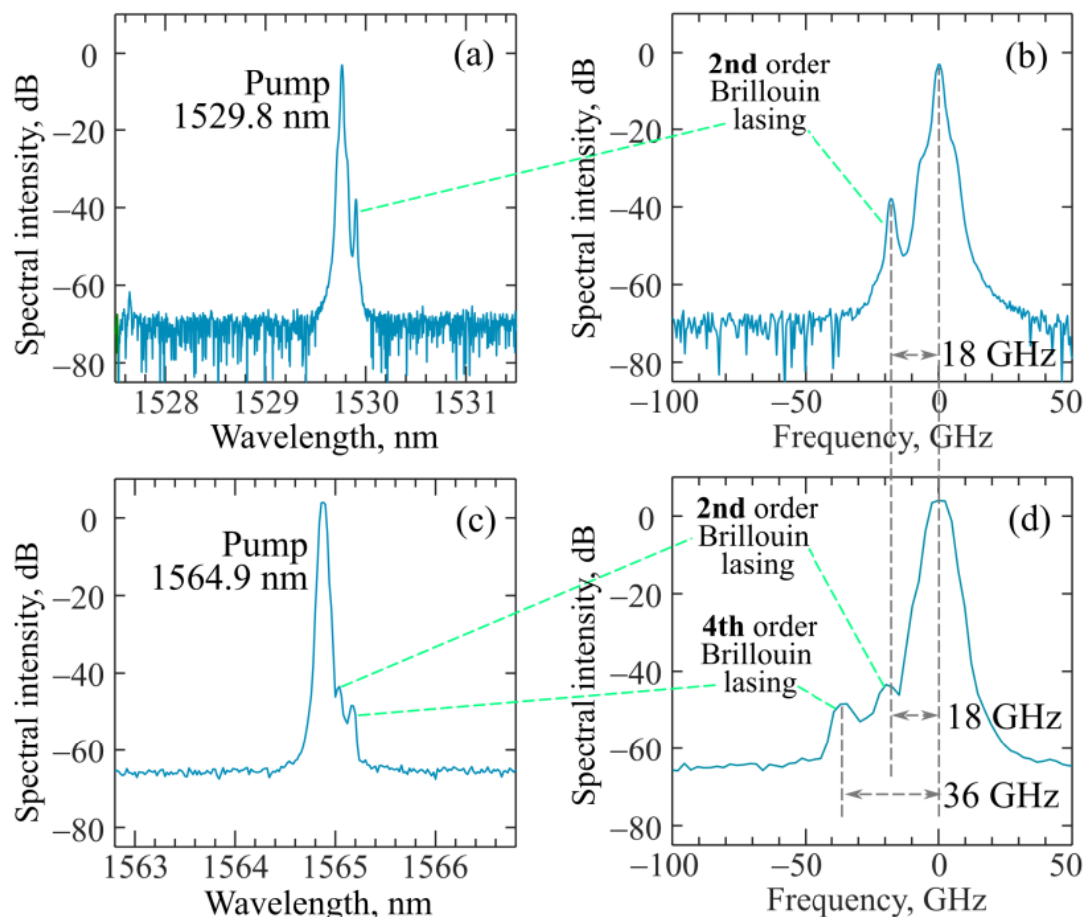
Figure 7. Experimental spectra measured for waves propagating co-directionally with pump. Spectra demonstrating cascade Stokes – Brillouin lasing: ( a , b ) of the 2nd order; ( c , d ) up to the 4th order.